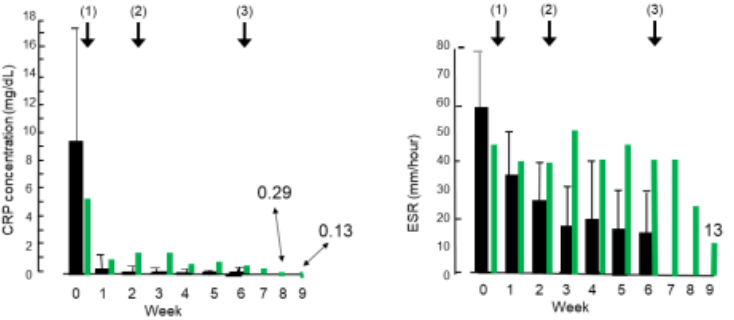
Figure 4. Change in C-reactive protein (CRP) concentration (left panel) and erythrocyte sedimentation rate (ESR) (right panel) before and after infliximab and plant-based diet as first-line (IPF) therapy followed by corticosteroid therapy for severe ulcerative colitis. The solid black bar denotes the mean, and the thin line shows SD in 13 patients with severe ulcerative colitis who achieved clinical remission with infliximab and plant-based diet as first-line (IPF) therapy [8]. The green solid bar denotes the values in the present case. Arrows with a number in brackets indicate three infliximab infusions, at weeks 0, 2, and 6. In a previous study [8], the normal range of CRP concentration was ≤0.3 mg/dL, and it was ≤0.14 in the present study. The normal range of ESR in males and females is ≤10 mm/h and ≤15 mm/h, respec tively.